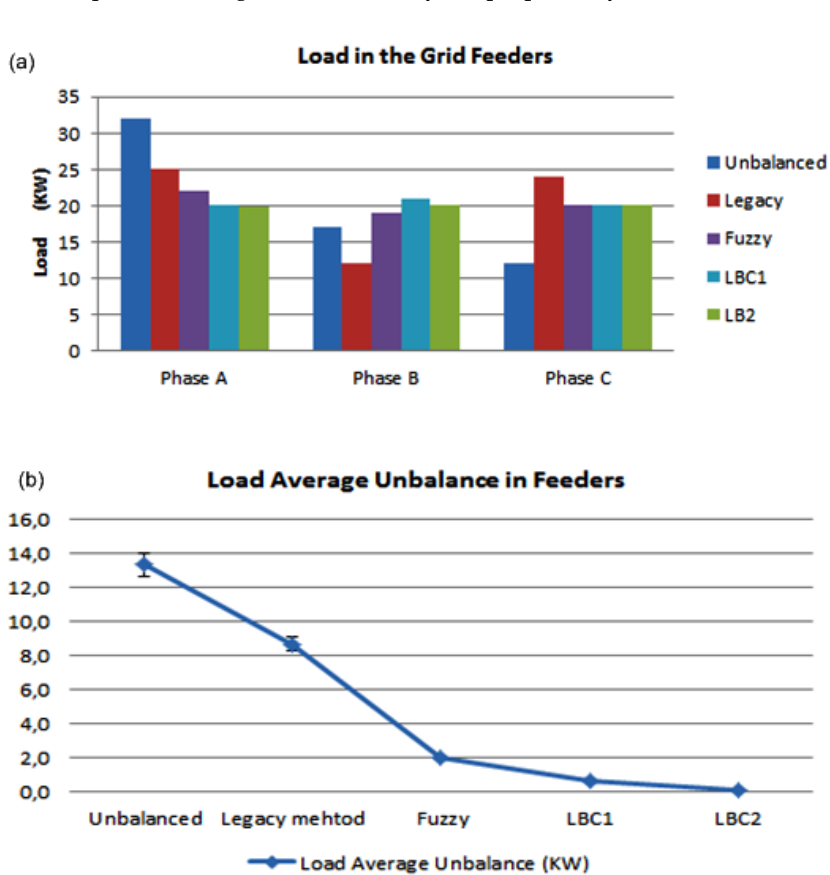
Figure 13. LBC system validation: ( a ) Load in the Grid Feeders; ( b ) Load absolute